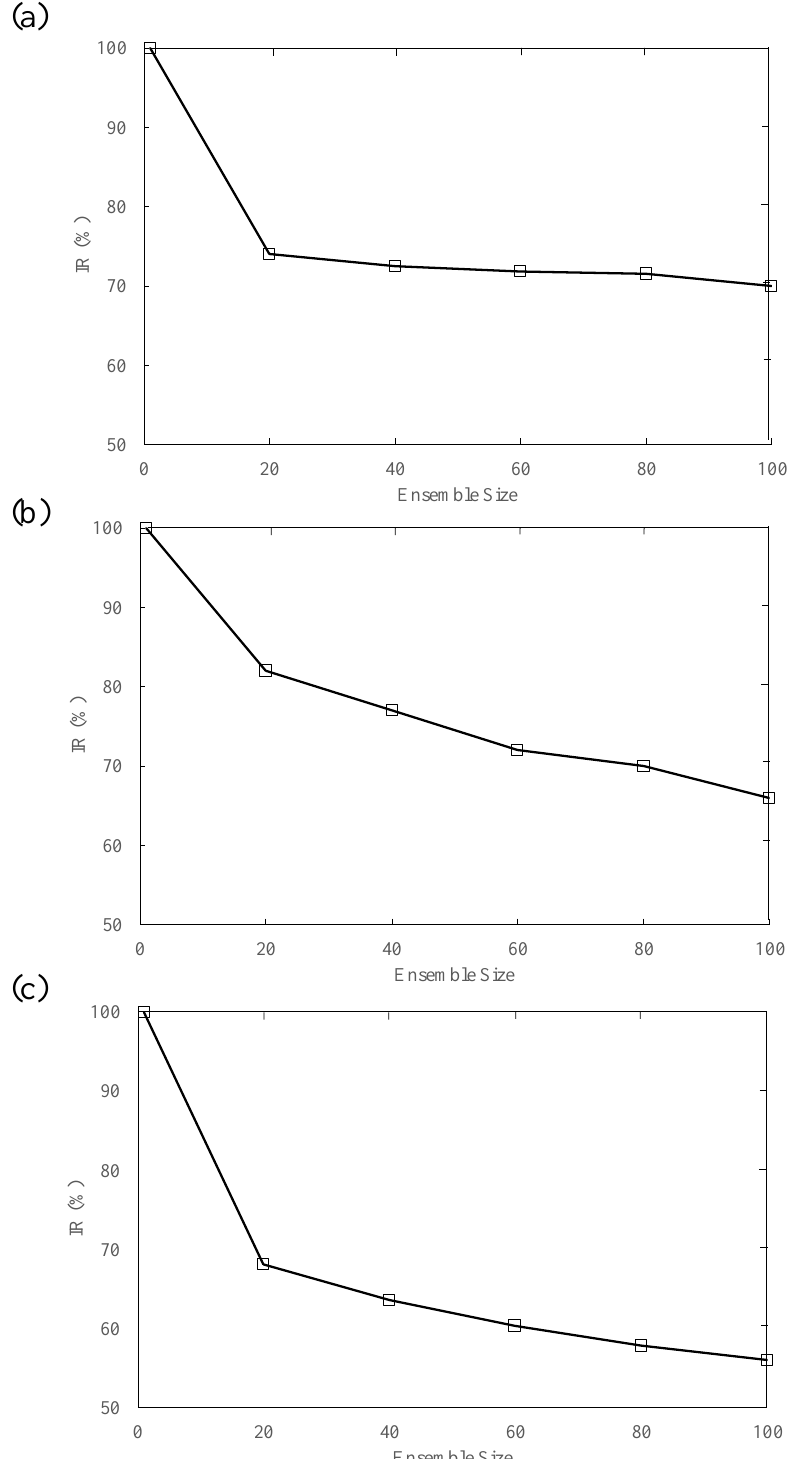
Figure 9. Performance of ( a ) cross-section elevation; ( b ) sediment concentration; ( c ) bed elevation by different ensemble sizes.